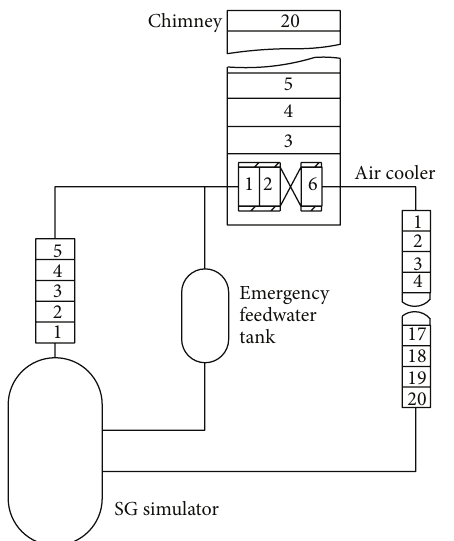
Figure 9: MASAP nodalization diagram of the test facility. where 𝛼 is void fraction; subscripts 𝑔 and 𝑓 stand for steam and saturated liquid, respectively.